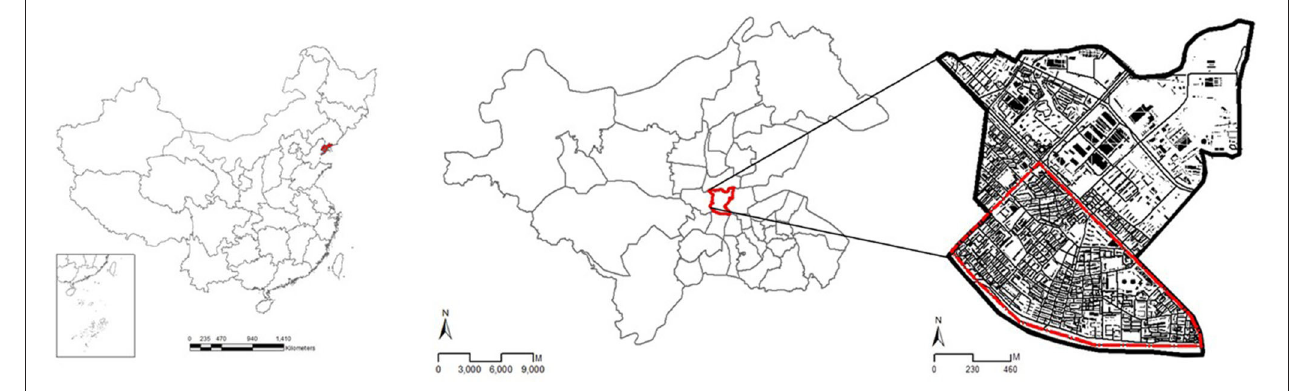
FIGURE 1 | Study site.